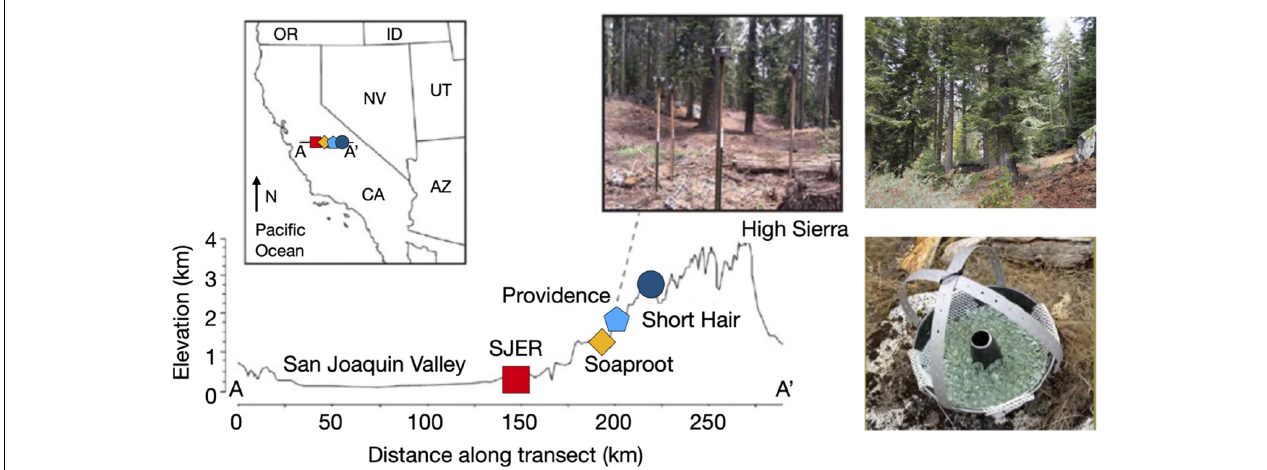
FIGURE 1 | Map of sampling transect, dust collectors, and sites along the elevation gradient. Map illustrating sites from the San Joaquin Valley (low elevation; red square indicating SJER, 400 m elevation) to the High Sierra (high elevation; dark blue circle symbolizing Short Hair, 2,700 m). Inset image on the map of the state of California, United States illustrates sampling transect from A-A’ with sites (left to right, SJER, Soaproot 1,100 m, Providence 2,000 m, Short Hair) increasing with distance from the Pacific Ocean and rising in elevation. Dust collectors deployed at Providence, to the right of the inset map. Photograph of the highest elevation site at Short Hair is shown on the top right. Photograph of the dust collector, composed of a Teflon-lined Bundt pan filled with glass marbles and lined with Kevlar mesh shown at the bottom right (adapted from Aciego et al., 2017 and Aarons et al.,